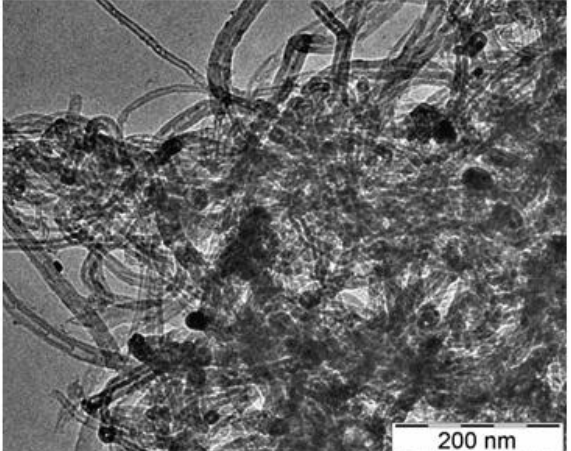
Figure 3. Representative electron microscopy images and EDX analysis of the investigated